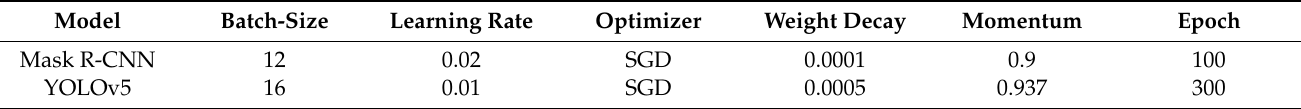
Table 1. Parameters of Mask R-CNN and